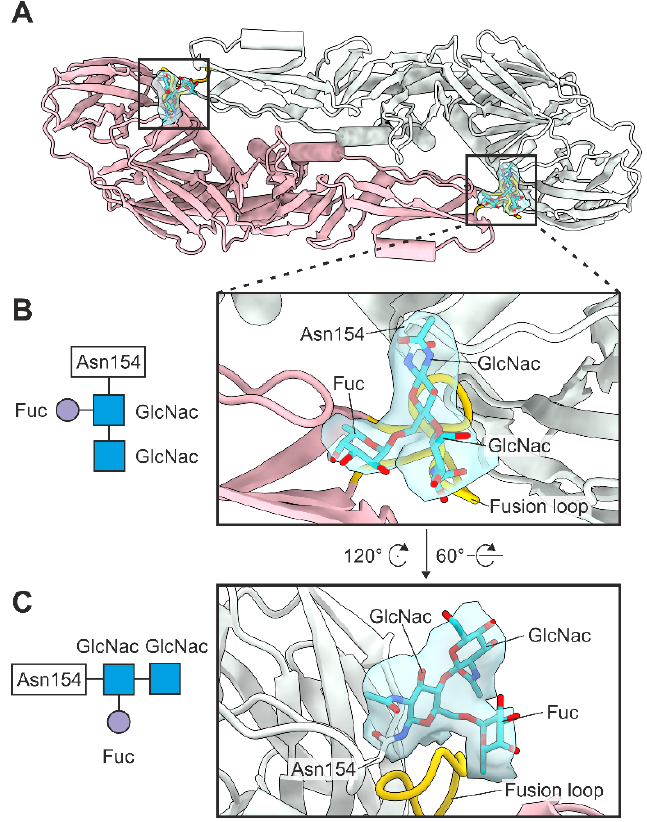
Figure 6. E protein glycosylation. ( A ) Top view of the E–E dimer. Chain A is coloured in light green and chain B in pink. Fusion loop (residues 100–109) is coloured in gold, and the glycan residues are coloured in turquoise with oxygens coloured in red and nitrogens in blue. The density corresponding to the glycans is shown in light blue. ( B , C ) Close-ups showing the position of the glycans relative to the fusion loop from two angles with Asn154 and the glycan residues labelled. The glycosylation of Asn154 is shown schematically to the left.